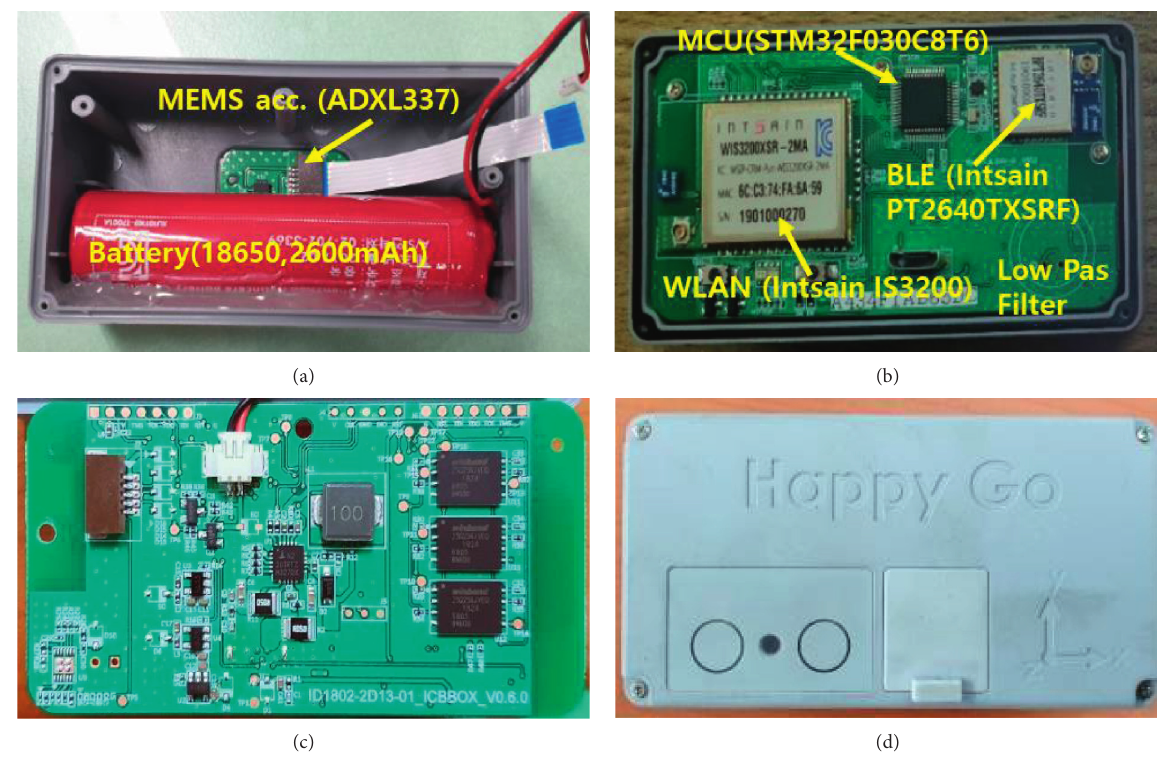
Figure 4: “Happy-Go” IoTdevice for the measurement of vibration: (a) MEMS accelerometer, (b) CPU, (c) IoTdevelopment platform, and (d) top-view of IoT